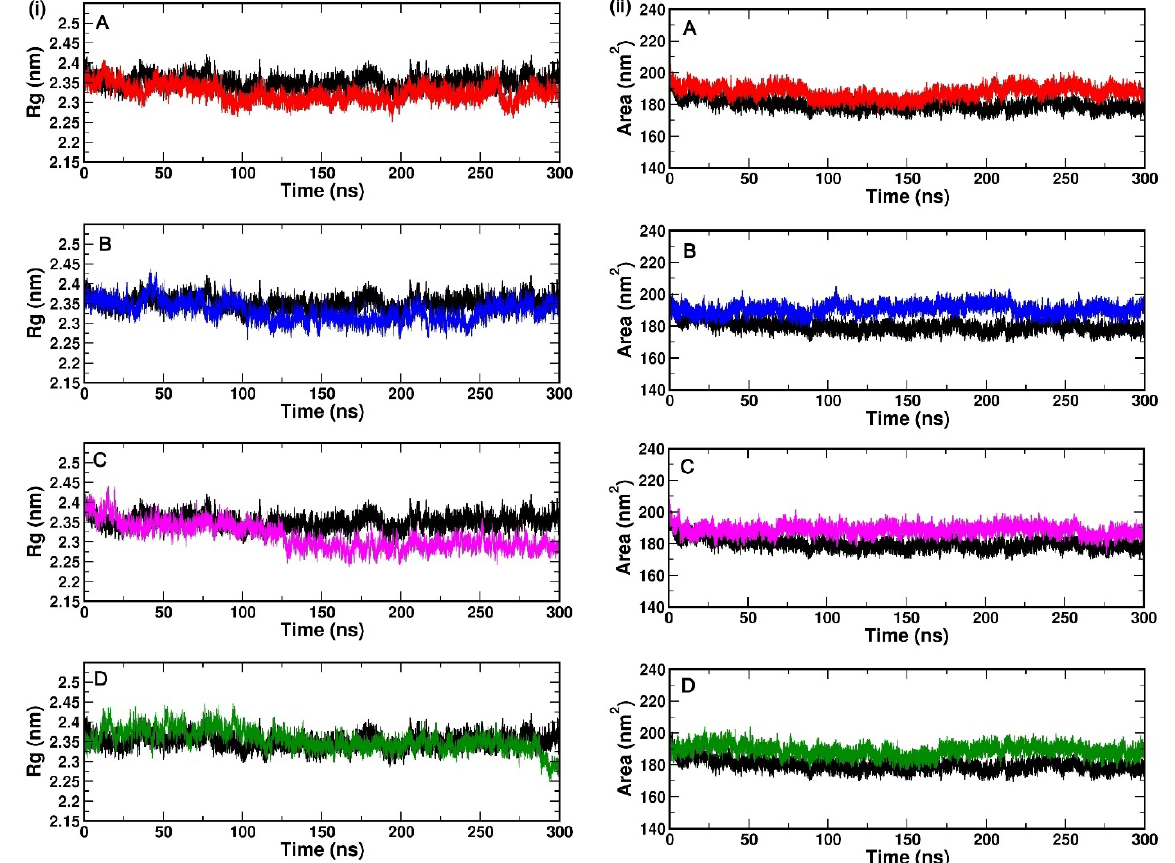
Figure 3. ( i ( A – D ))—Rg values of backbone atoms over 300 ns simulation of different (Plpro-ISG15)- complex with phytochemicals (AG1 (red), GU1 (blue), TU1 (magenta), and GRL0617 (green)) ( left ). ( ii ( A – D ))—SASA values of backbone atoms over 300 ns simulation for different (Plpro-ISG15)- complexes with phytochemicals (AG1 (red), GU1 (blue), TU1 (magenta), and GRL0617 (green)) ( right ). The black line represents (Plpro-ISG15)-complex without